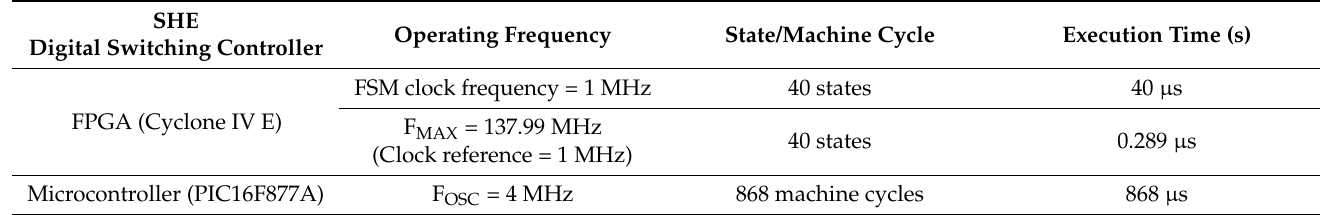
Table 8. 21-level SHE digital switching controller implemented in FPGA (Cyclone IV E) and micro- controller